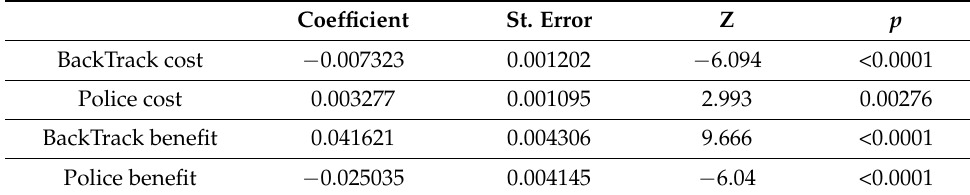
Table 3. Statistical